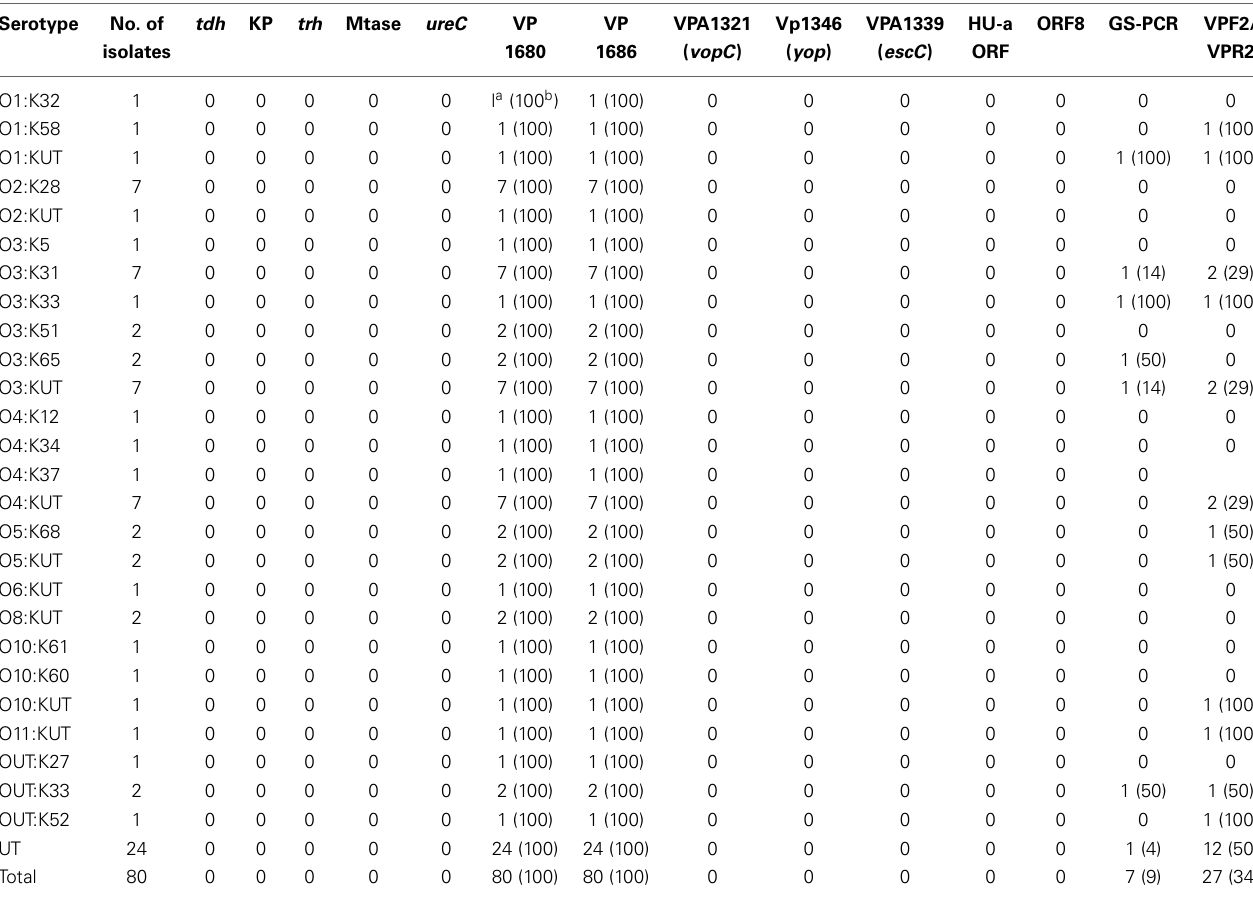
Table 2 | Molecular characteristics of serotyped strains. Serotype